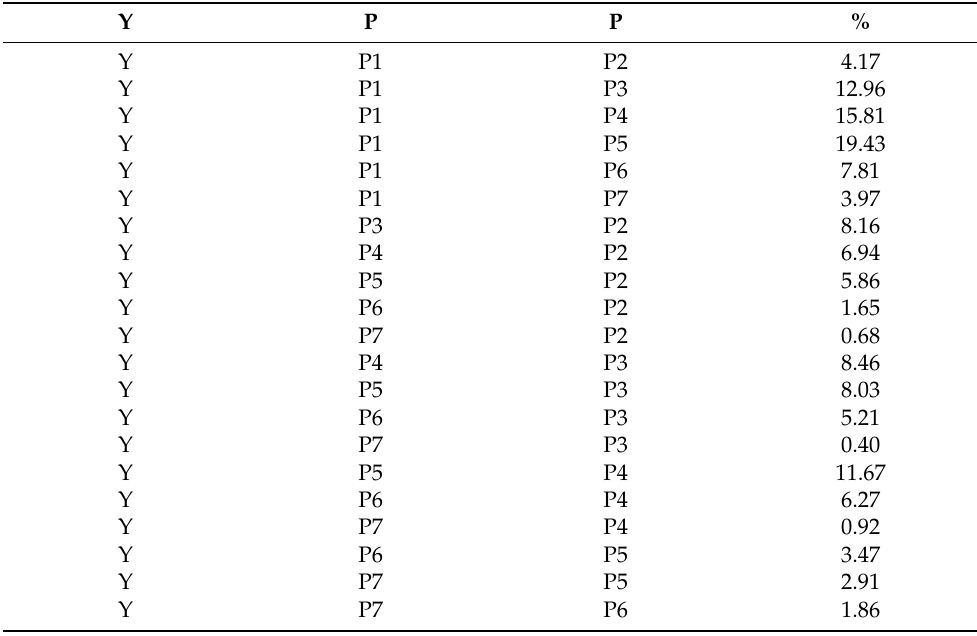
Table 6. Successfulness of the models, derived from the GP method, where we combined two parameters from Table 1 that describe the properties of the torrential fans or the properties of their hinterland. The best model is highlighted in gray and was derived using Parameters P3 and